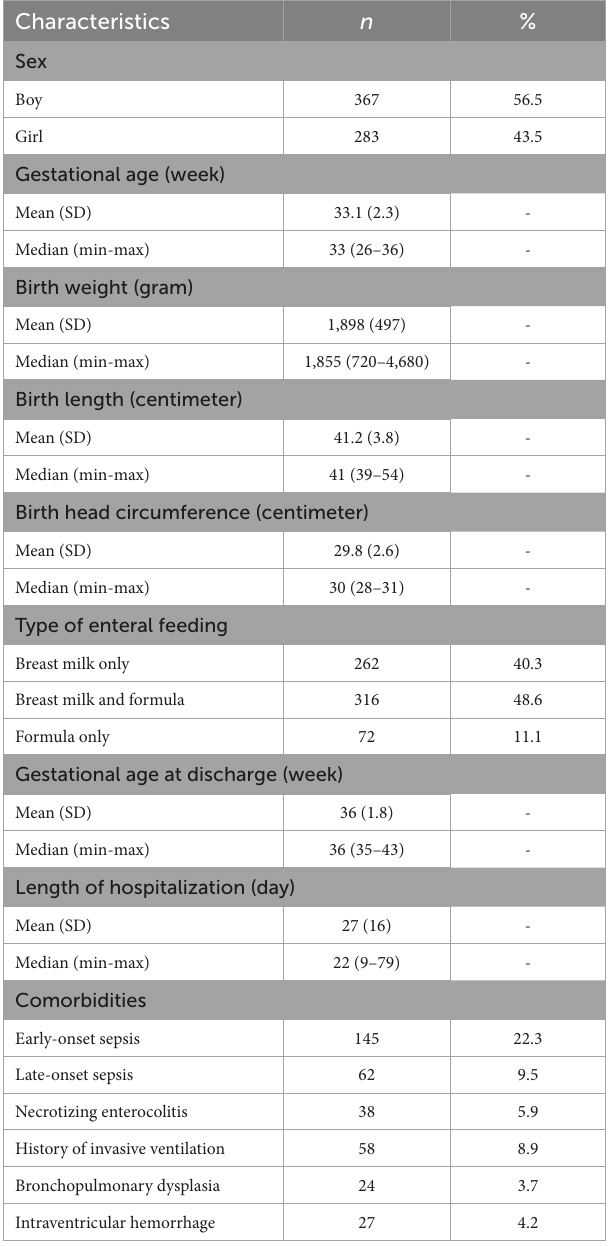
TABLE 1 Demographic data of the study